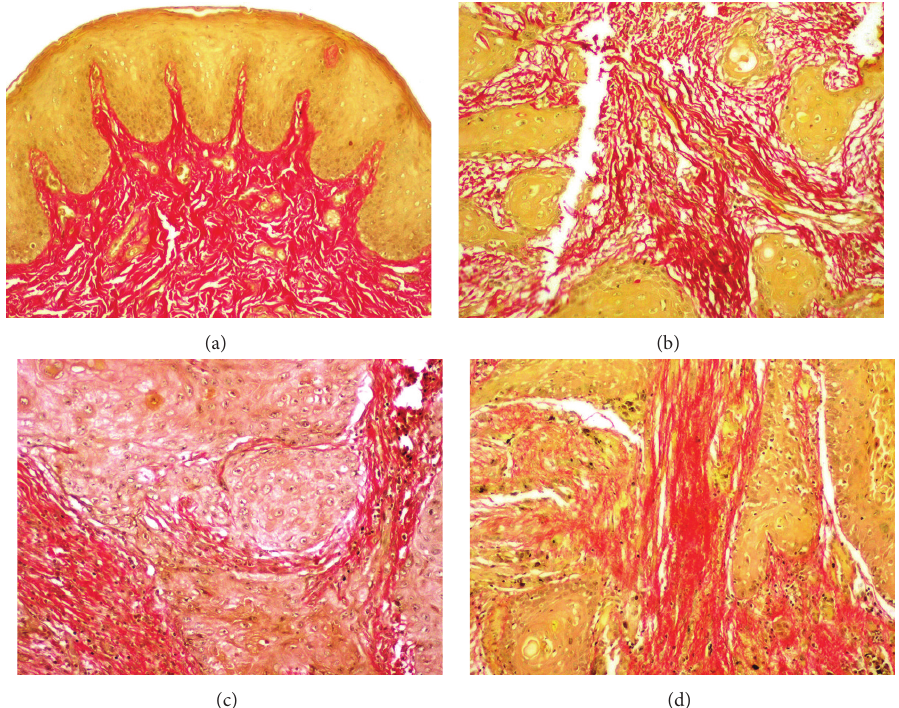
Figure 1: Photomicrograph of PSR stained sections under bright field microscope (10x) showing collagen stained deep red. (a) NM. (b) WDSCC. (c) MDSCC. (d)